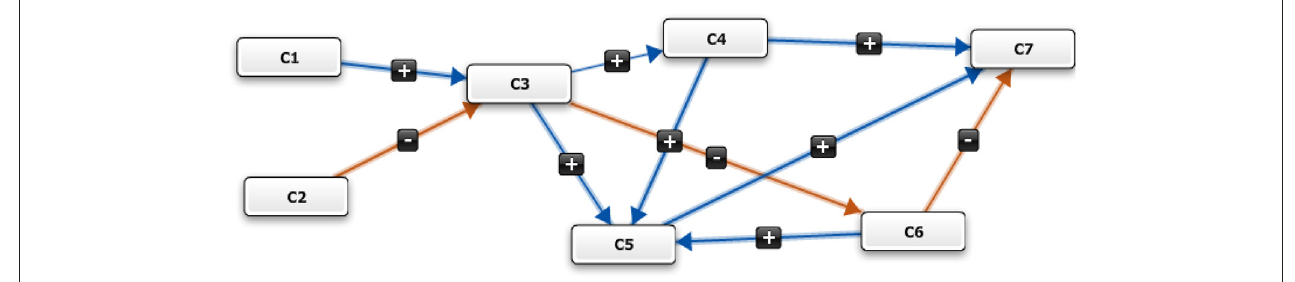
FIGURE 1 | A typical FCM graph depicting positive and negative causalities between